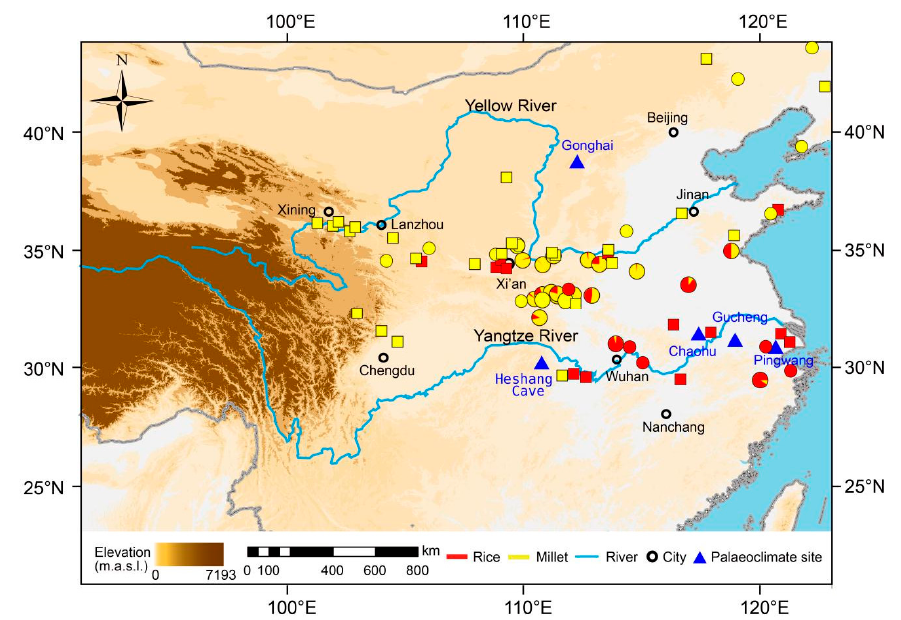
Figure 2. The spatial pattern of crop macro-fossils from sites dated between 7000–5000 BP in China. Squares represent sites without detailed archaeobotanical data; circles represent sites with detailed archaeobotanical data.